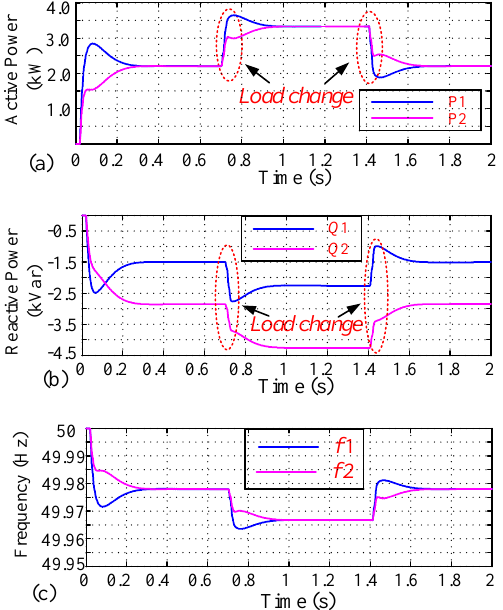
Figure 11. Simulation results in Case D: ( a ) active power; ( b ) reactive power; and ( c ) frequency.